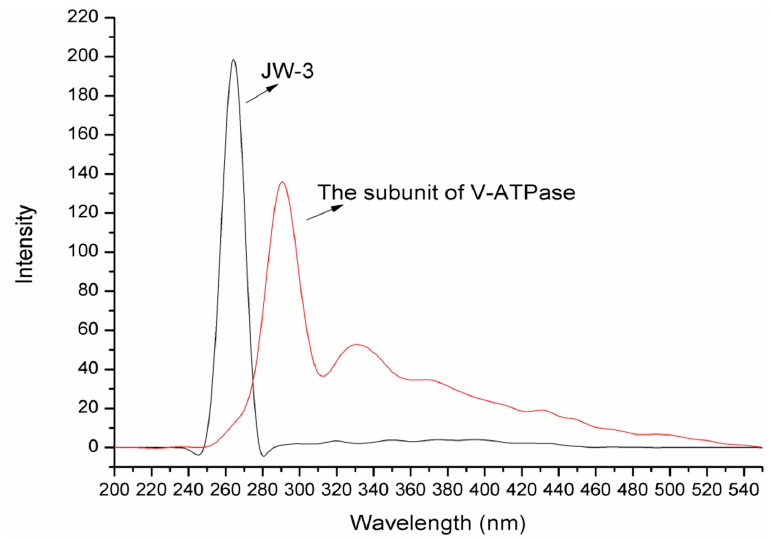
Figure 2. The synchronous fluorescence spectra of of both JW-3 and the H subunit of V-ATPase at a constant offset value Δλ = 15 nm.